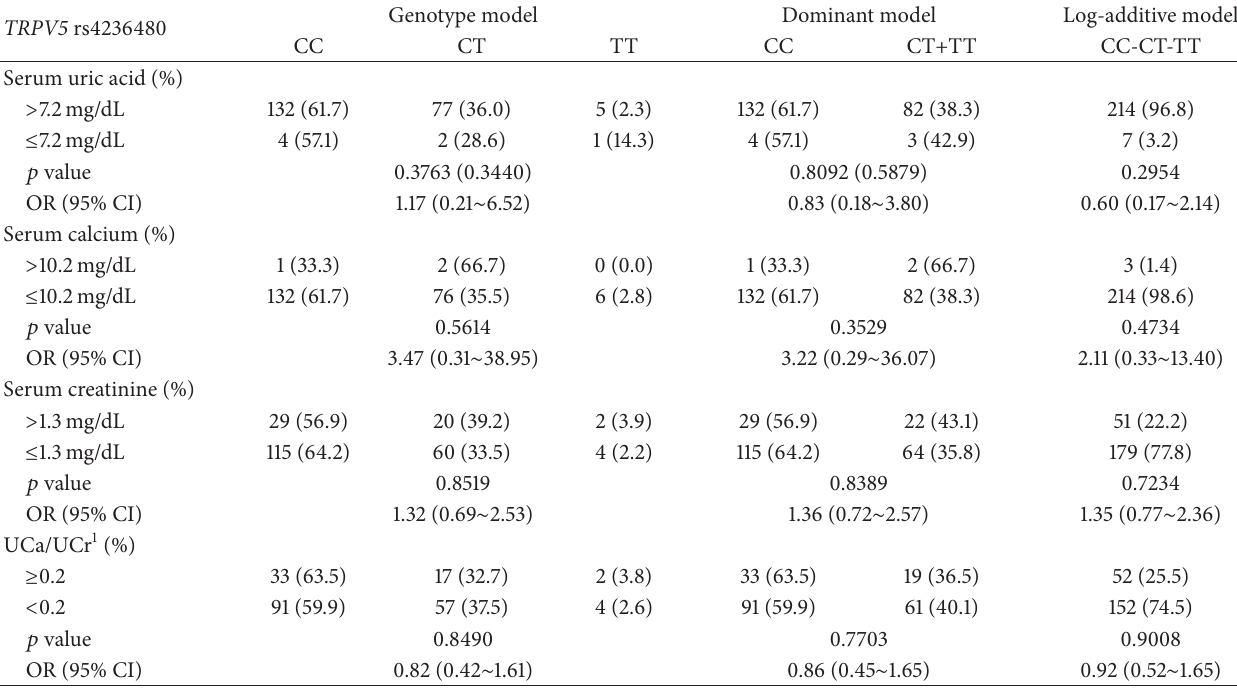
Table 5: Association analysis of TRPV5 rs4236480 and subgroups of clinical biochemical